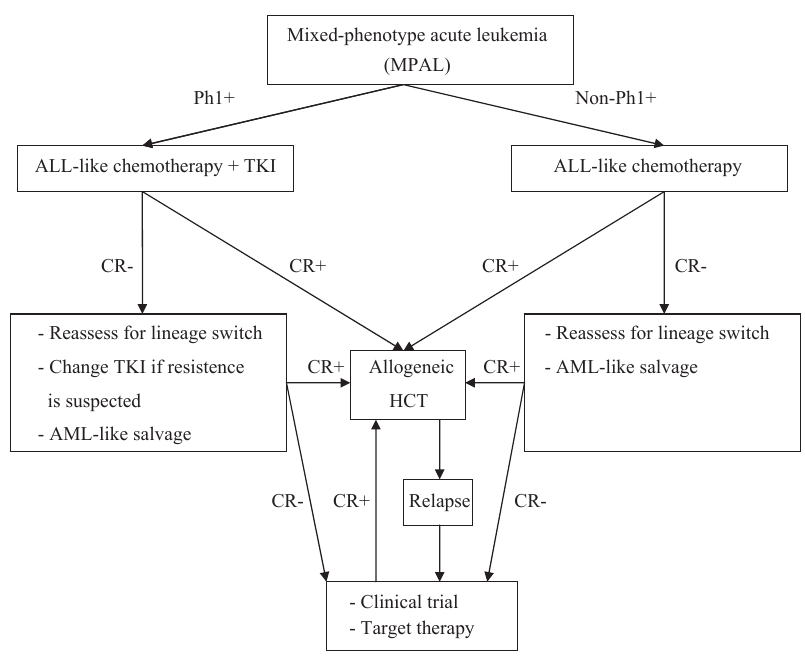
Fig. 1. Algorithm for treating patients with